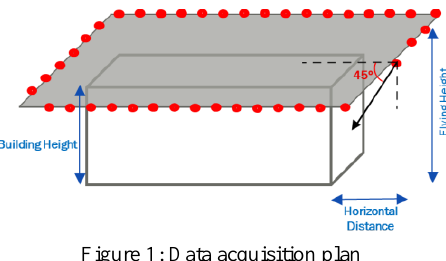
Figure 1: Data acquisition